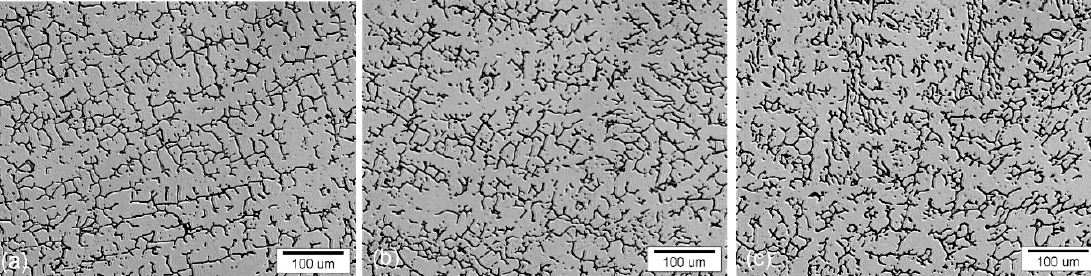
Figure 5. Evolution of morphology of δ -ferrite in microstructure after 5 min annealing at 1050 °C ( a – c ), 1150 °C ( d – f ), and 1250 °C ( g – i ). Locations are 3 mm ( a , d , g ), 10 mm from the edge ( b , e , h ), and center of the ingot ( c , f , i ). Microstructural changes taking place during the heat treatment of stainless steel are complex [23]. A visual assessment of the specimen’s microstructure suggests some differ- ences, both in terms of the morphology and the distribution of the ferrite. In general, an elevated-temperature treatment leads to the dissolution of the metastable ferrite [23]. In addition, it was noticed that the dendritic network of the ferrite breaks down and tends to spheroidize. After annealing, a reduction of the ferrite content is observed, and accom- panied by an increase in the size of the individual ferrite islands and a change in shape to more spherical. The difference in the free-energy levels of the metastable ferrite and the stable transformation products acts as the driving force for the dissolution process. As a